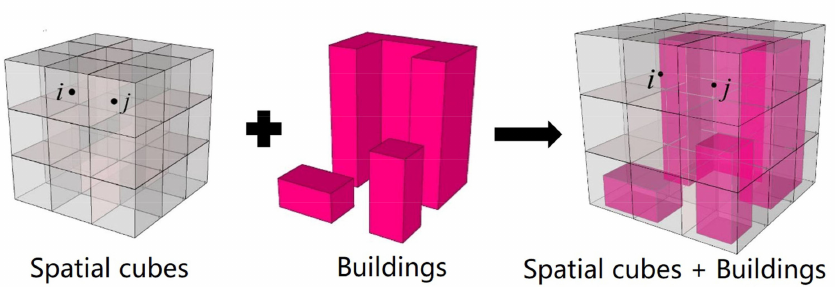
Figure 4. Schematic diagram of the spatial cube division of three-dimensional (3D) urban space